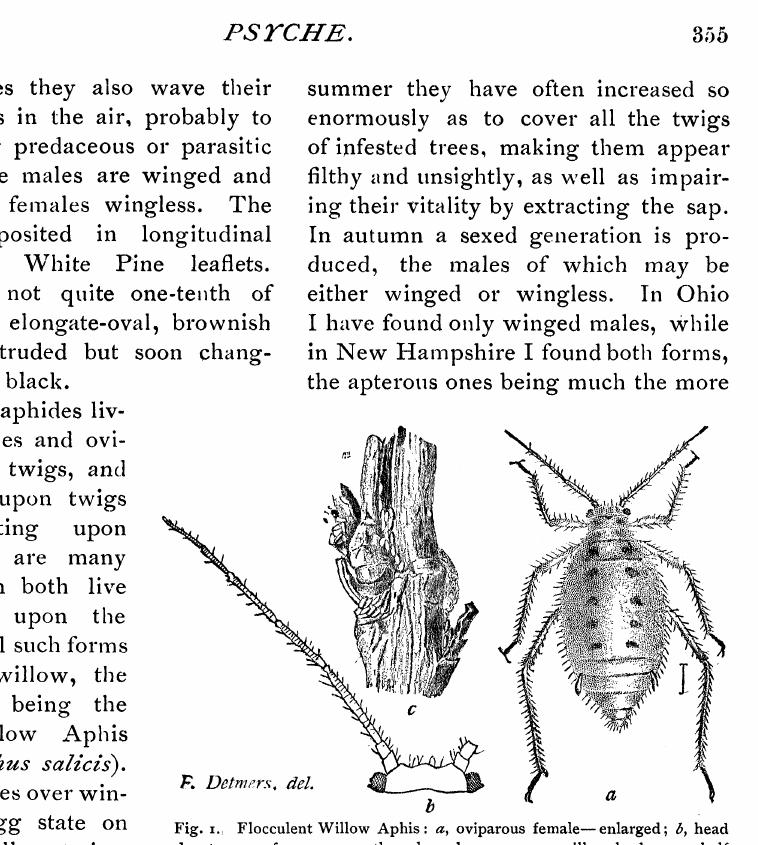
., Flocculent Willow Aphis: a, oviparous female--enlarged; Fig. and antennae of greatly enlarged; c, eggs willow bark- one-half larger than natural